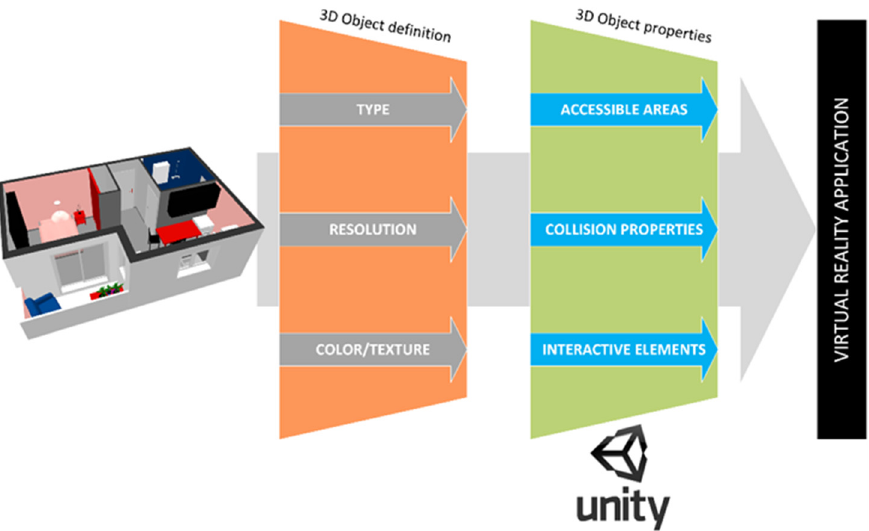
Figure 3. Schema with the two steps that must be carried out for the adaptation of 3D models for their use in virtual reality applications. The first one, 3D object definition, was external to Unity, and the second one, 3D object properties, was carried out within the Unity application.